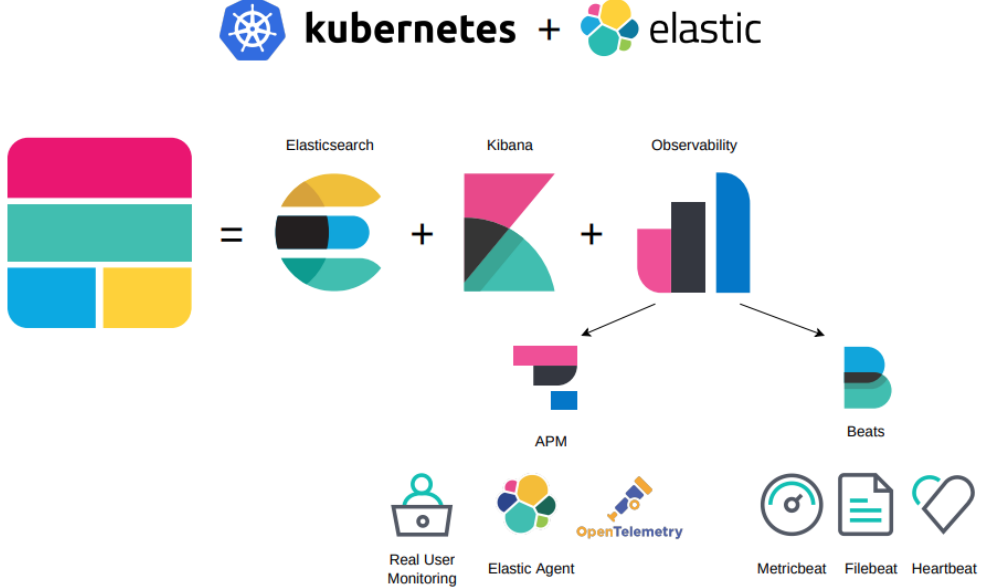
Figure 2. Overview of the Elastic Stack